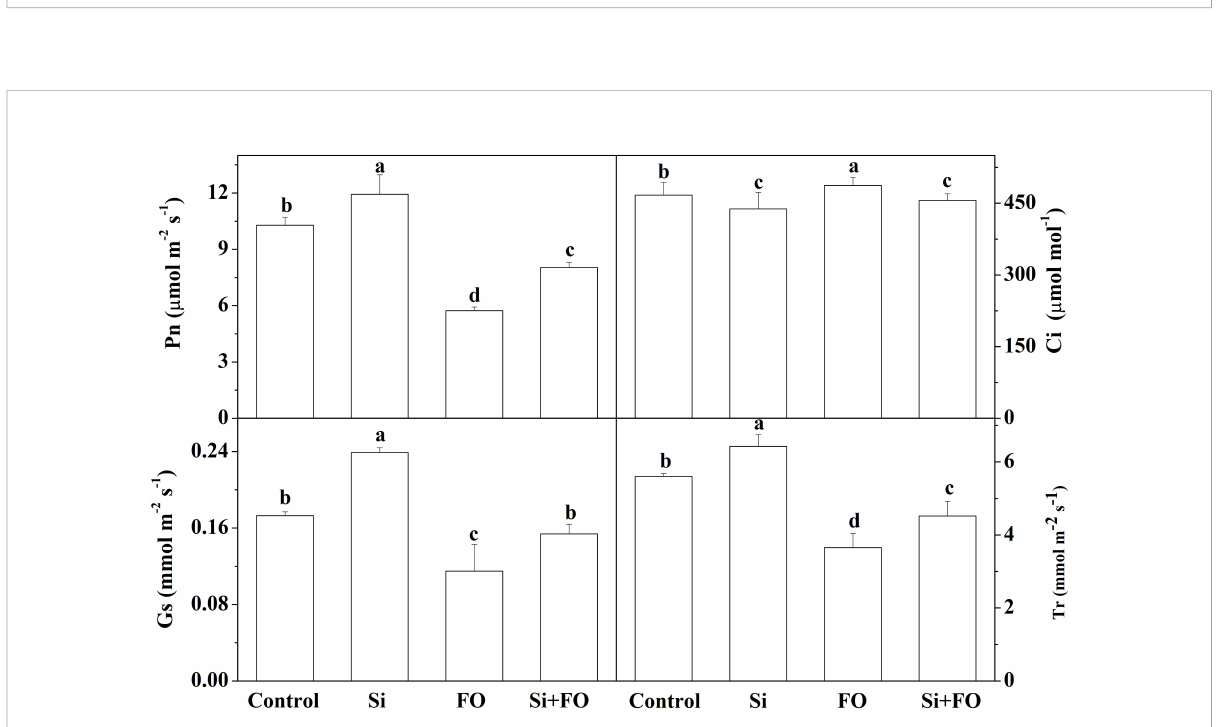
FIGURE 5 Effects of exogenous silicon application on Pn, Ci, Gs, and Tr in cucumber leaves. Means denoted by the different lowercase letters are signi fi cantly different according to Tukey ’ s test ( P ≤ 0.05); the mean represents the average of three replicates ± standard deviation (SD). Control: plants were irrigated with sterilized water; Si: plants were irrigated with exogenous silicon (3 mmol·l -1 Si); FO: plants were only inoculated with Fusarium ; Si+FO: plants were irrigated with exogenous silicon followed by inoculation with Fusarium. .